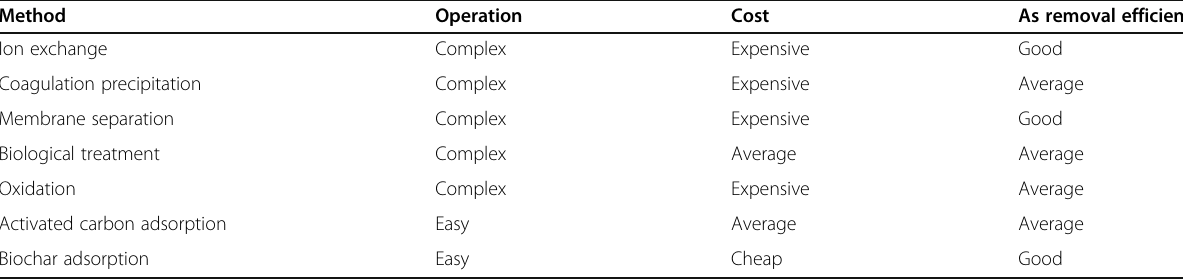
Table 1 Comparison for the removal of arsenic by different technologies Method Coagulation precipitation Biological treatment Oxidation Activated carbon adsorption Biochar